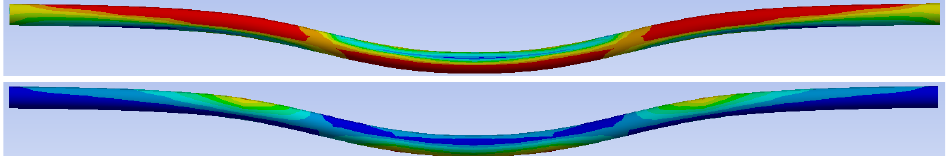
Figure 29. Experiment B: Stress in fasteners during connection collapse (MPa) (on the ( left )), plastic deformation in fasteners during connection collapse (-) (on the ( right ).